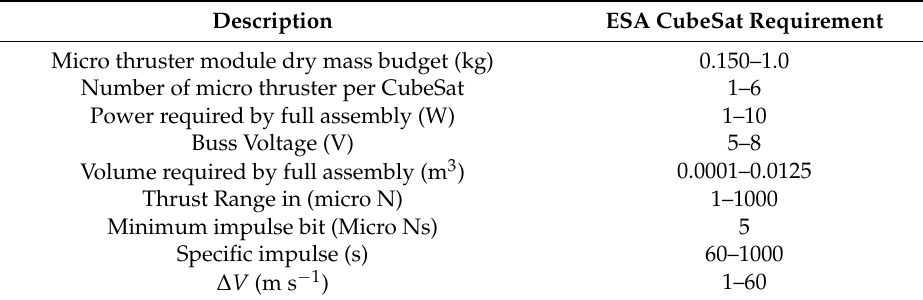
Table 25. ESA CubeSat Propulsion System Requirements